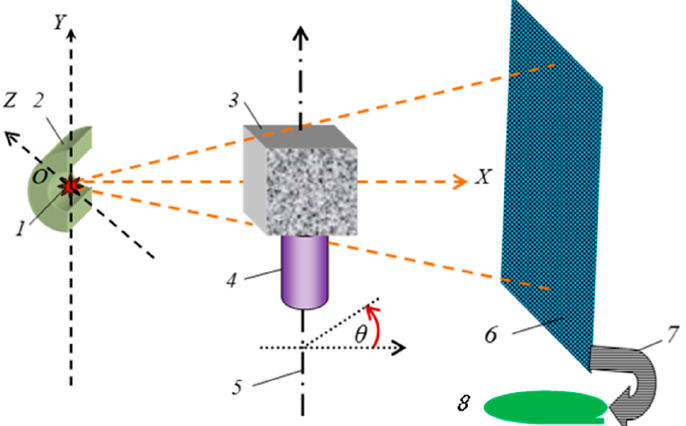
Figure 3. Schematic of projection system geometry in three-dimensional space using non-destruc- tive X-ray imaging: 1 –radiation source, 2 − radiation shielding, 3 –test specimen, 4 − stage of a micro- scope, 5 − axis of rotation, 6 –planar detector, 7 –information channel, 8 − memory and digital signal processing device.